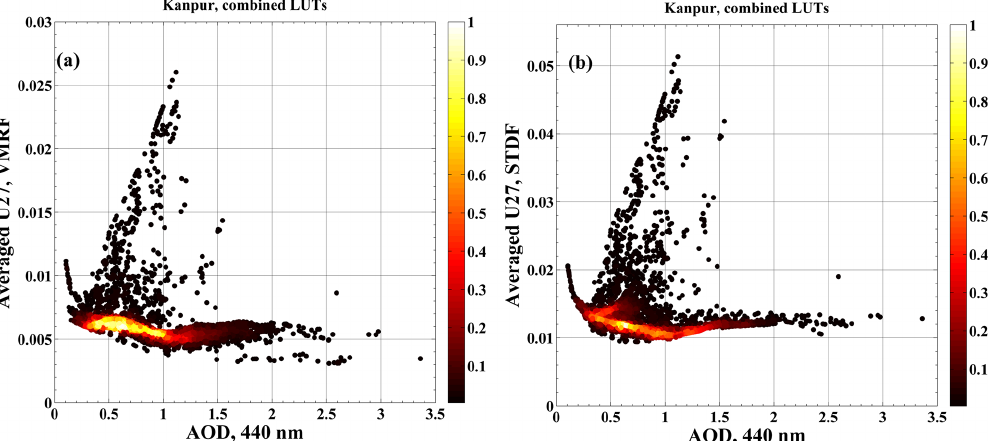
Figure 29. Uncertainties for (a) volume median radius of fine mode and (b) width of size distribution for fine mode estimated at the Kanpur